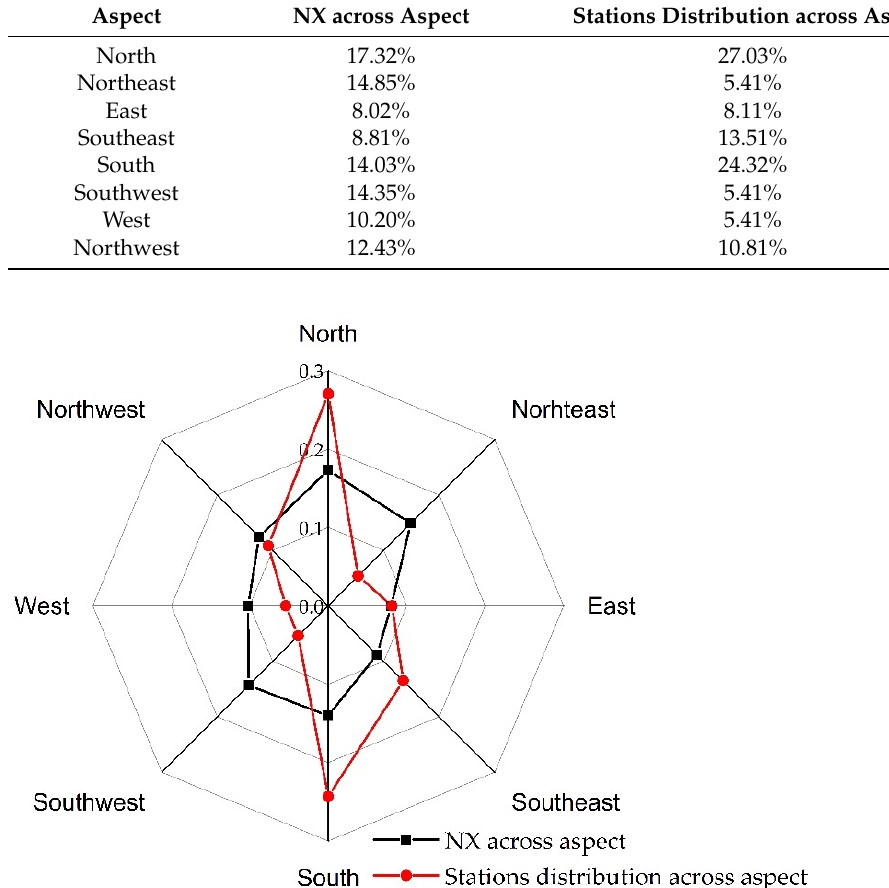
Figure 14. Comparison between stations distribution and NX across aspect.